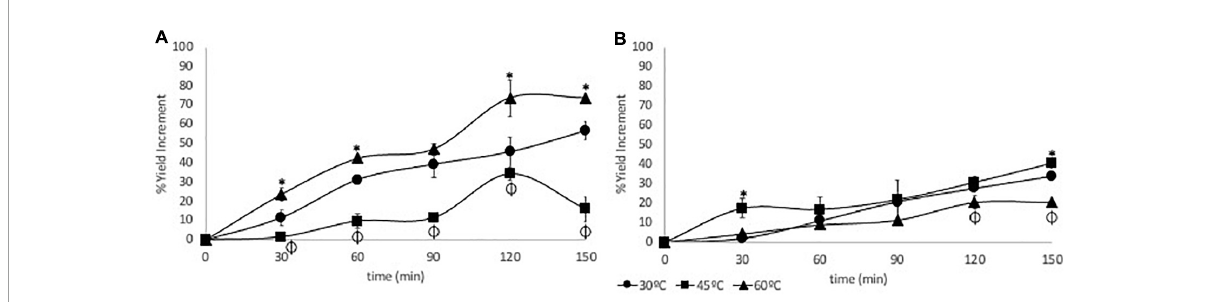
FIGURE2 Extraction yield increase at different enzyme-assisted extraction (EAE) time periods using an enzyme concentration of 2,500 UI/L (A) or 250 UI/L (B) . ( ∗ ) Highest increase at each sampling time after Tukey statistical test, and ( φ ) lowest increase at each sampling time after Tukey statistical